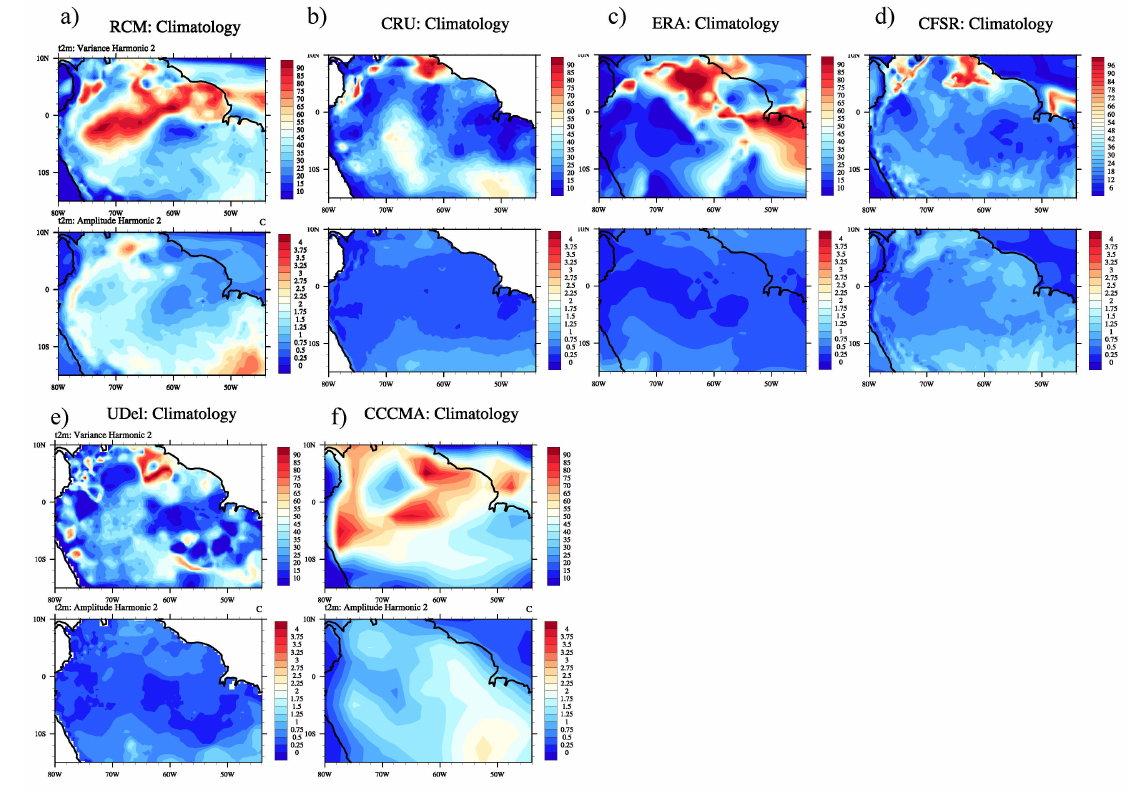
Figure 2. The same as in Figure 1 but for the second harmonic. ( a ) PD-RCM simulation ( b ) CRU, ( c ) ERA-Interim, ( d ) CFSR, ( e ) University of Delaware dataset, and ( f ) the